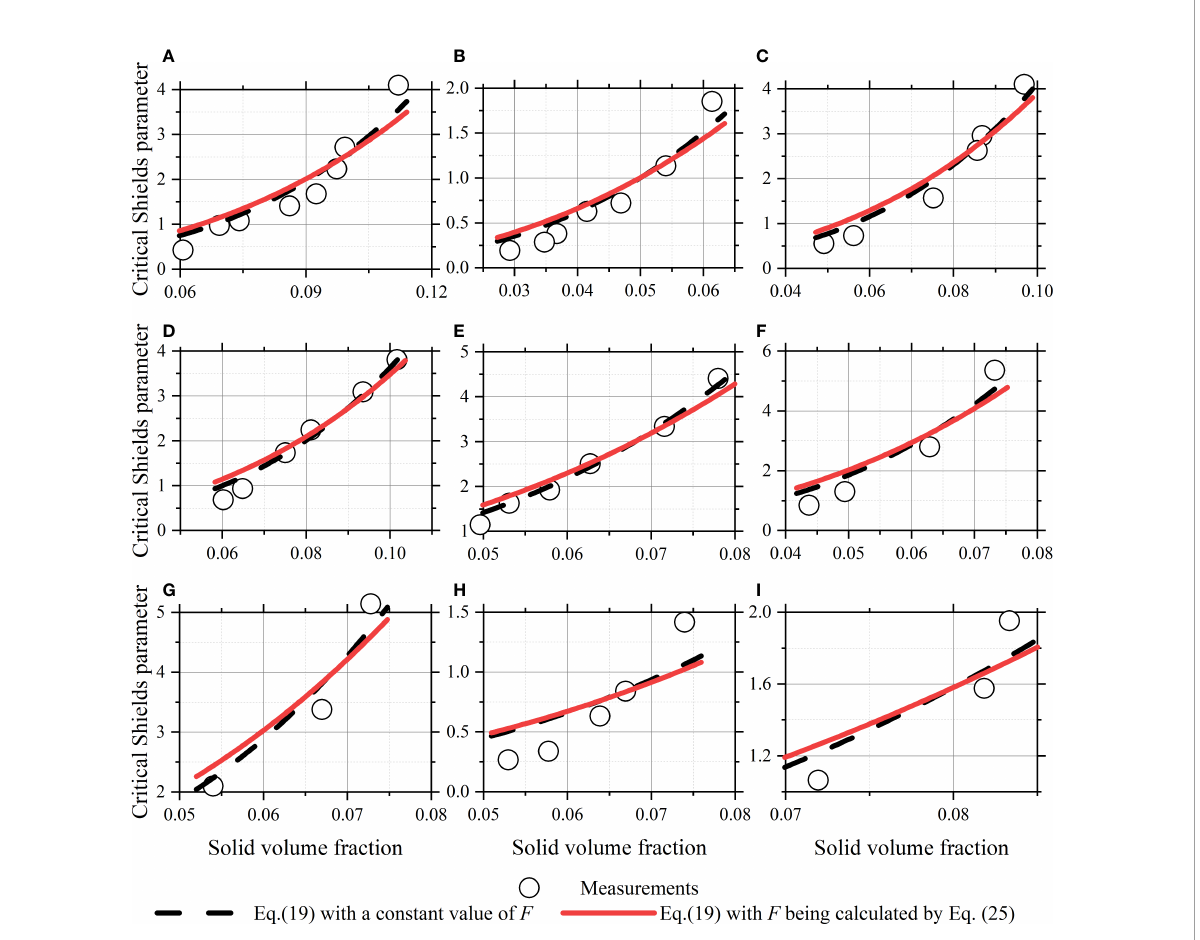
FIGURE 3 Applications of the developed formula in lake and pond mud. (A) Kasumi Lake mud; (B) Kasumigaura Lake mud; (C) Teganuma Pond mud; (D) Ushikunuma Pond mud; (E) Hinuma Lake mud; (F) Yunoko Lake mud; (G) Suwako Lake mud; (H) Harunako Lake mud; (I) Inbanuma Lake